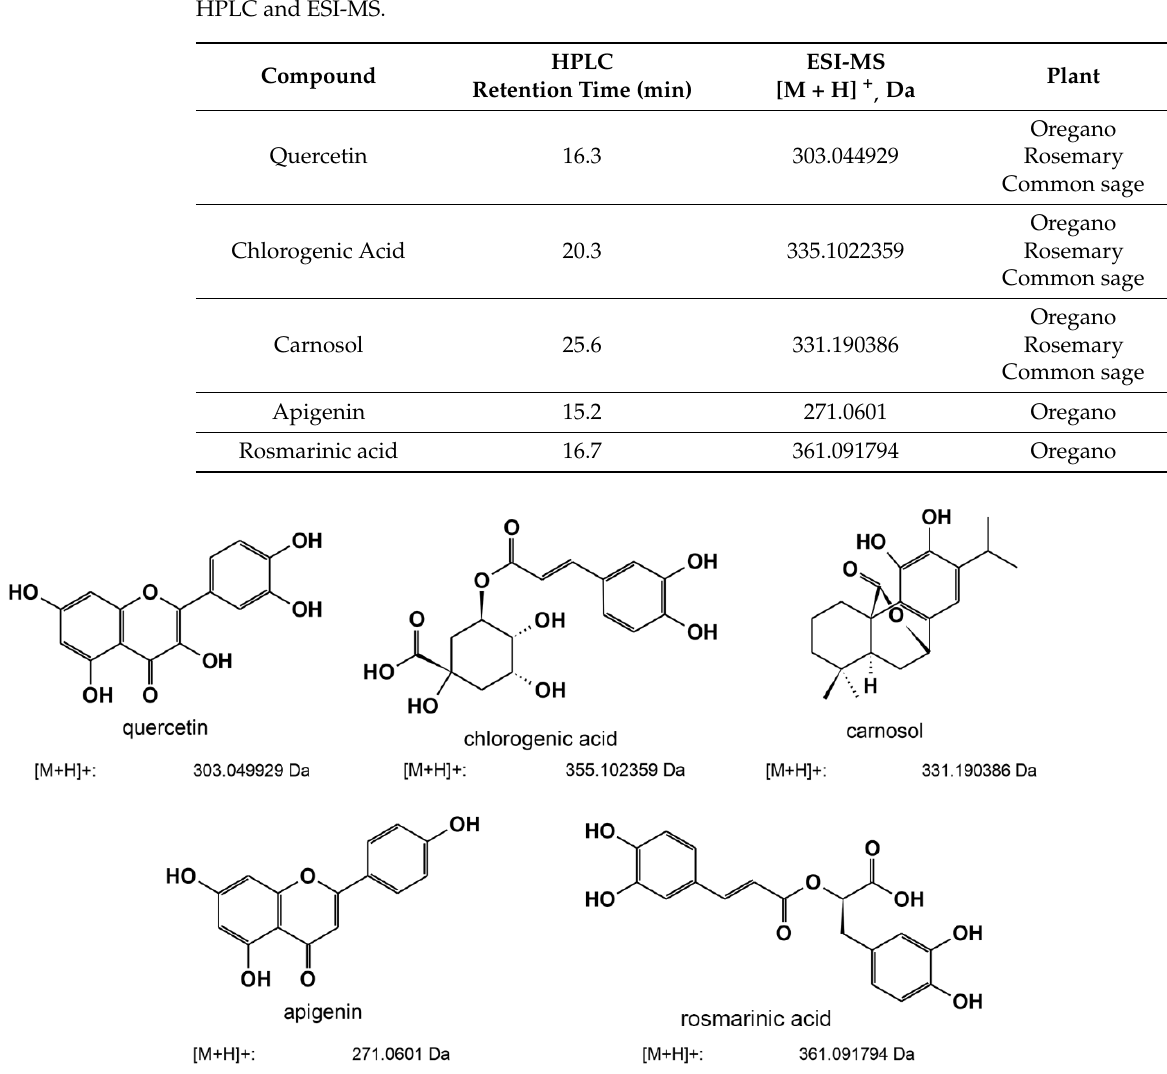
Figure 5. Chemical structures of the active compounds detected in the ethanolic extracts of oregano, rosemary, and common sage through LC ‐